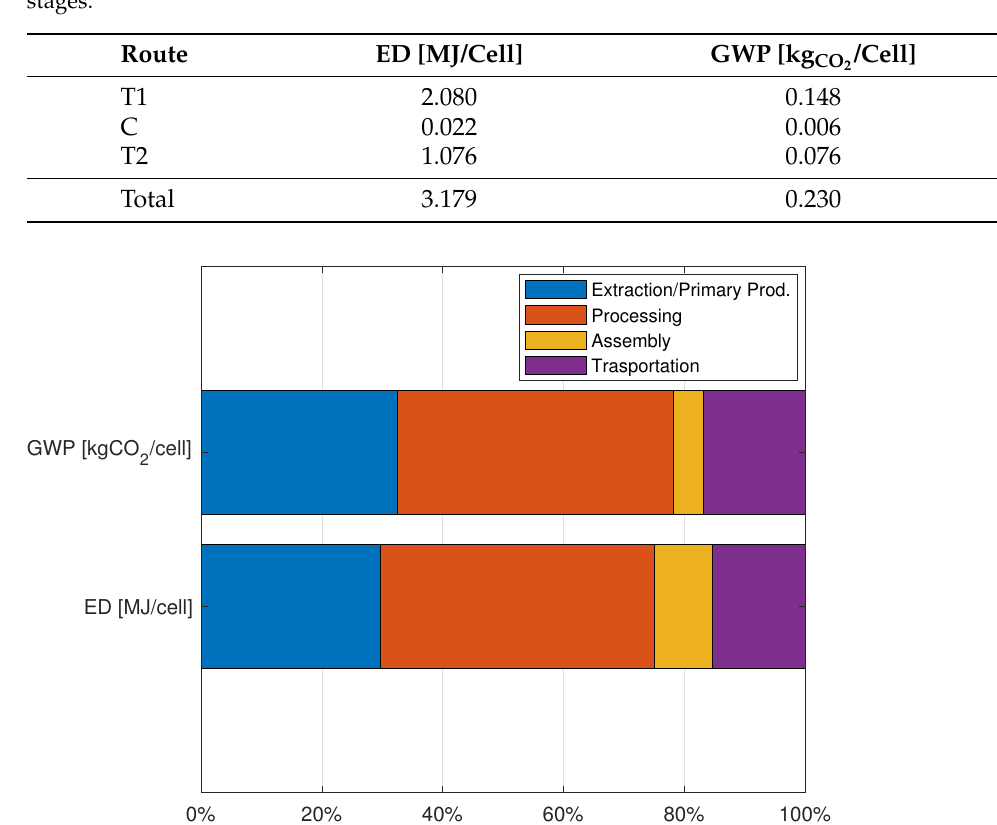
Figure 7. Average ED and GWP related to the raw materials extraction and processing, and the assembly and transportation of the